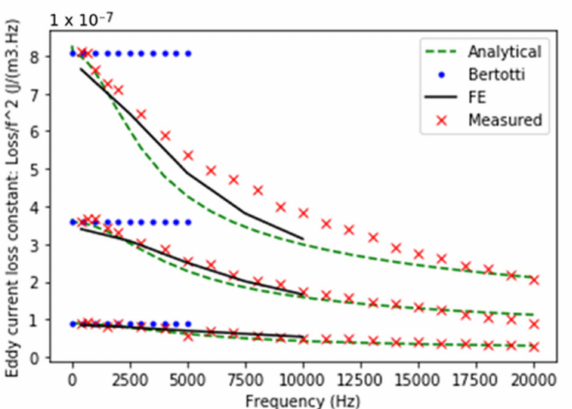
Figure 6. Predicted and measured eddy current loss density as function of frequency, for sinusoidal polarisation waveforms with peak amplitudes of 0.05 T, 0.1 T and 0.15